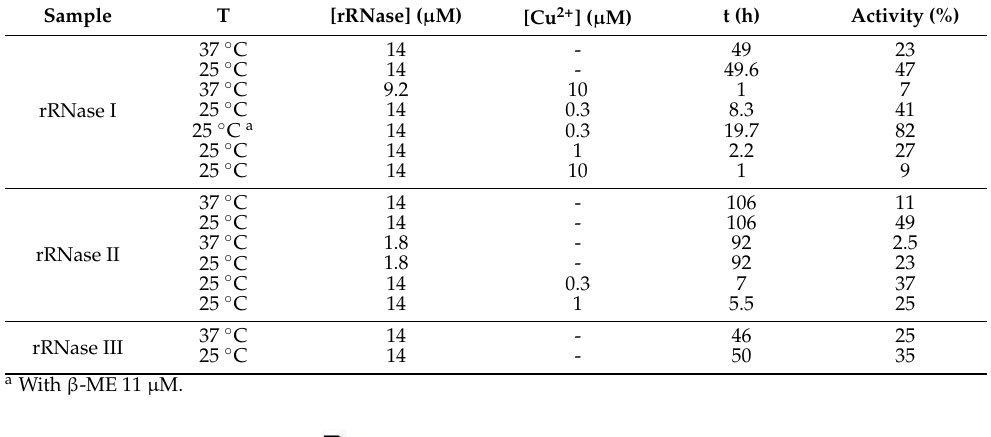
Table 1. Experiments of re-oxidation of rRNases.